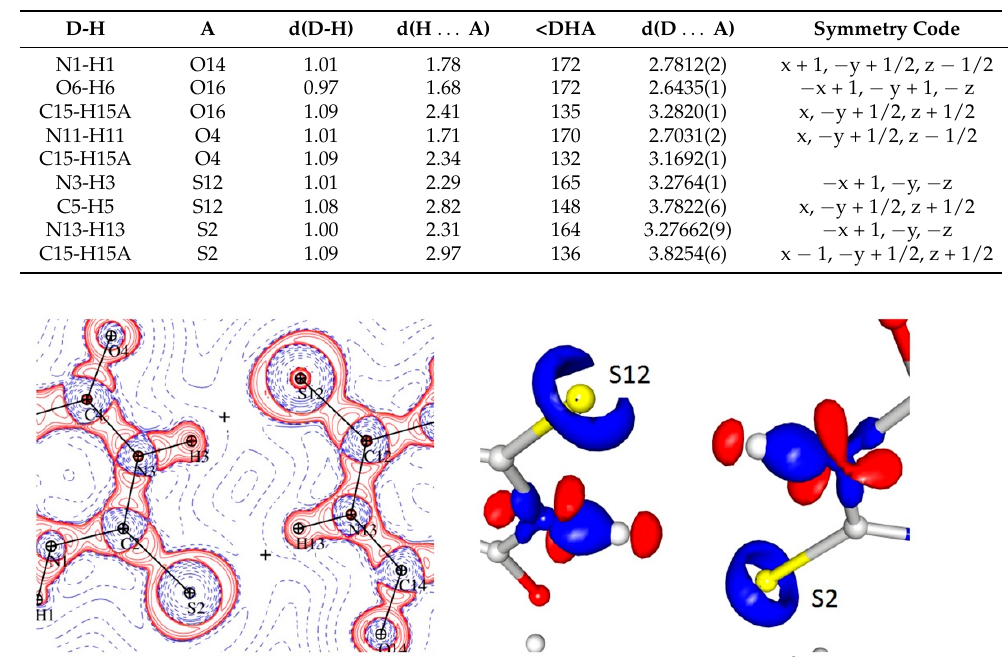
Table 5. HB geometrical parameters (Å, ◦ ).